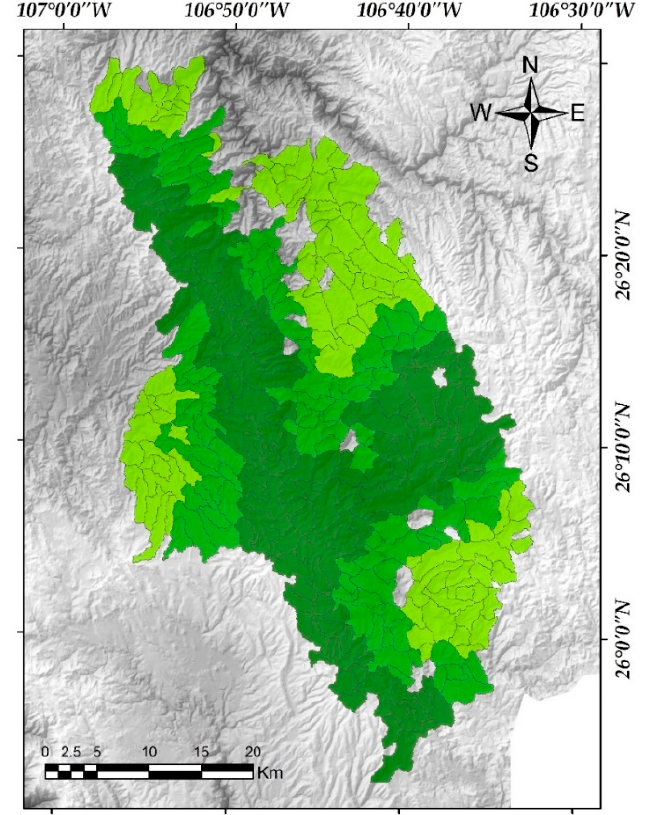
Figure 7. Spatial distribution of the tree clusters defined by group analysis. Group 1( ● ), Group 2( ● ), Group 3( ● ). Name of colors: Bilbao ( ● ), Limeade ( ● ), Inch Worm ( ● ).